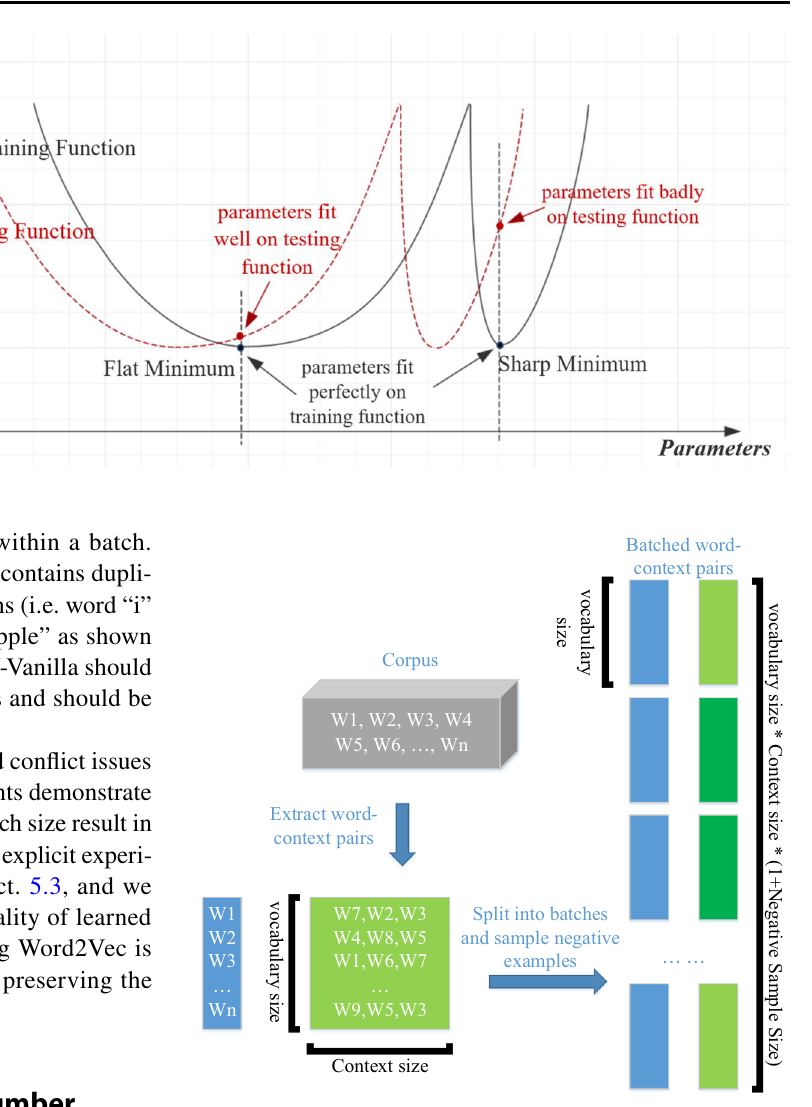
Fig. 6 Illustration of W2V-CL model Table 4 Illustration of word–context matrix M (without randomness) for sentence “i like apple juice” (window size is 2, context size is